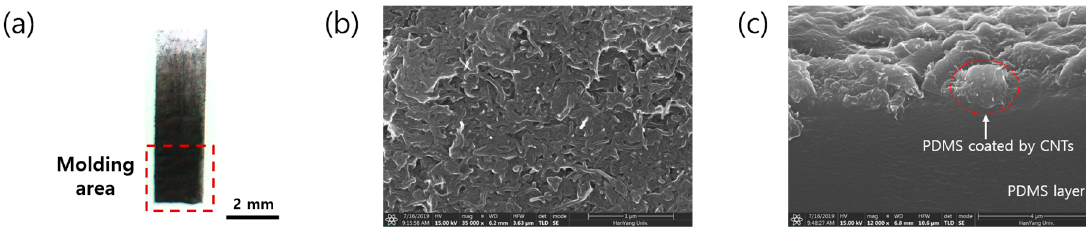
Figure 3. ( a ) Optical image of the CNT–PDMS composite used in the sensor; ( b ) Top-view and ( c ) cross-sectional SEM images.